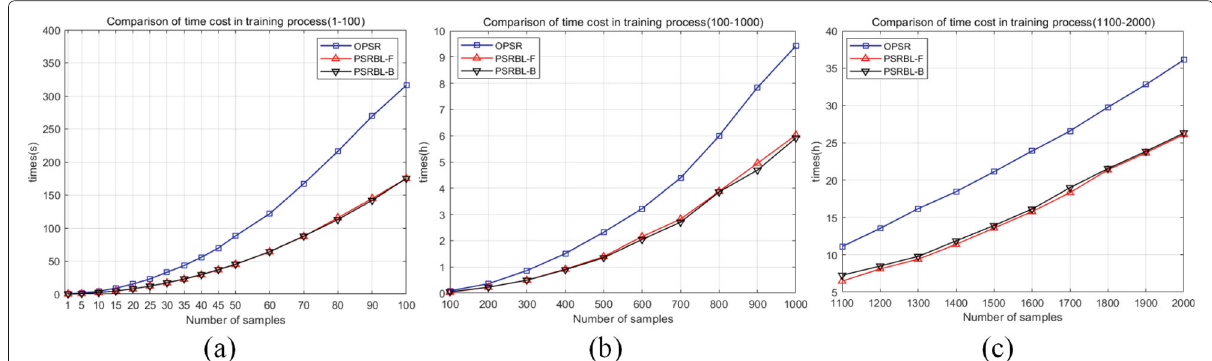
Fig. 5 The computation time of frameworks PSRBL and